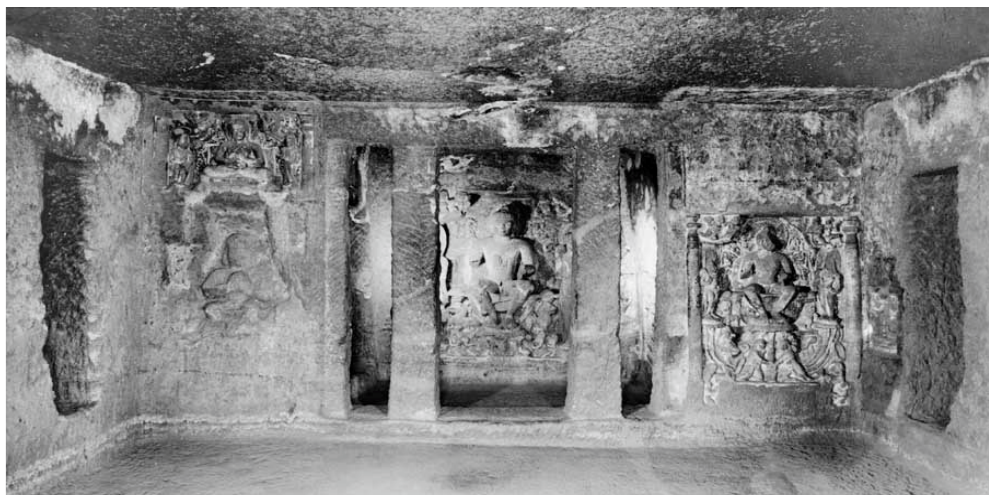
Figure 7. Intrusive panels from Aja ṇṭ ā Cave 22, overview of the cave and the main shrine, ca. 478–480 CE (Courtesy of AIIS # 96798).